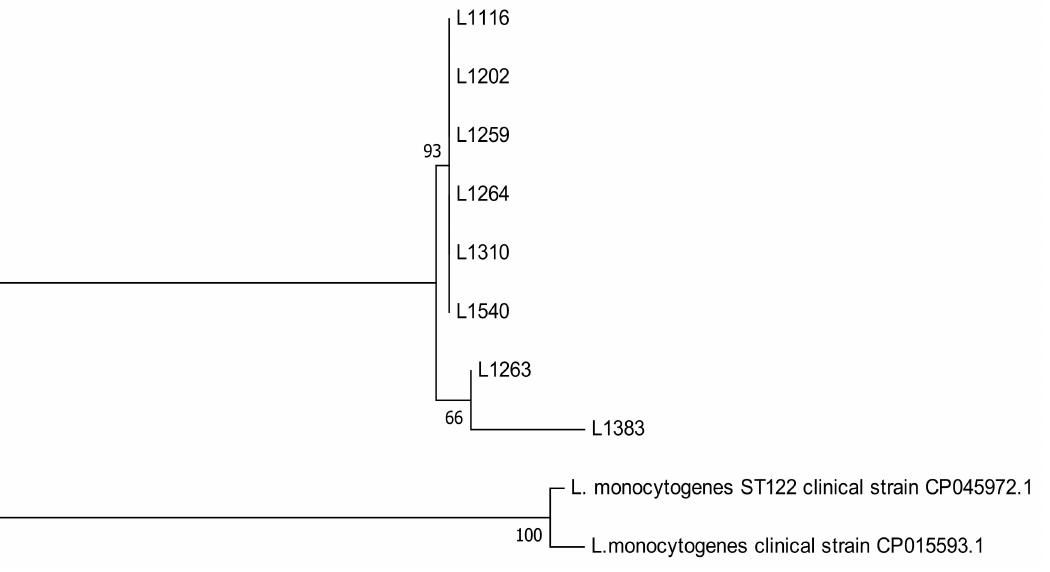
Figure 1. Phylogenetic tree of hlyA sequencing of Listeria monocytogenes identified in the study and two L. monocytogenes reference strains of clinical origin. The tree with the highest log likelihood ( − 469.20) is shown. The initial tree for the heuristic search was automatically obtained by applying Neighbor–Join and BioNJ algorithms to a matrix of pairwise distances estimated using the Maximum Composite Likelihood (MCL) approach. Evolutionary analyses were conducted with MEGA7